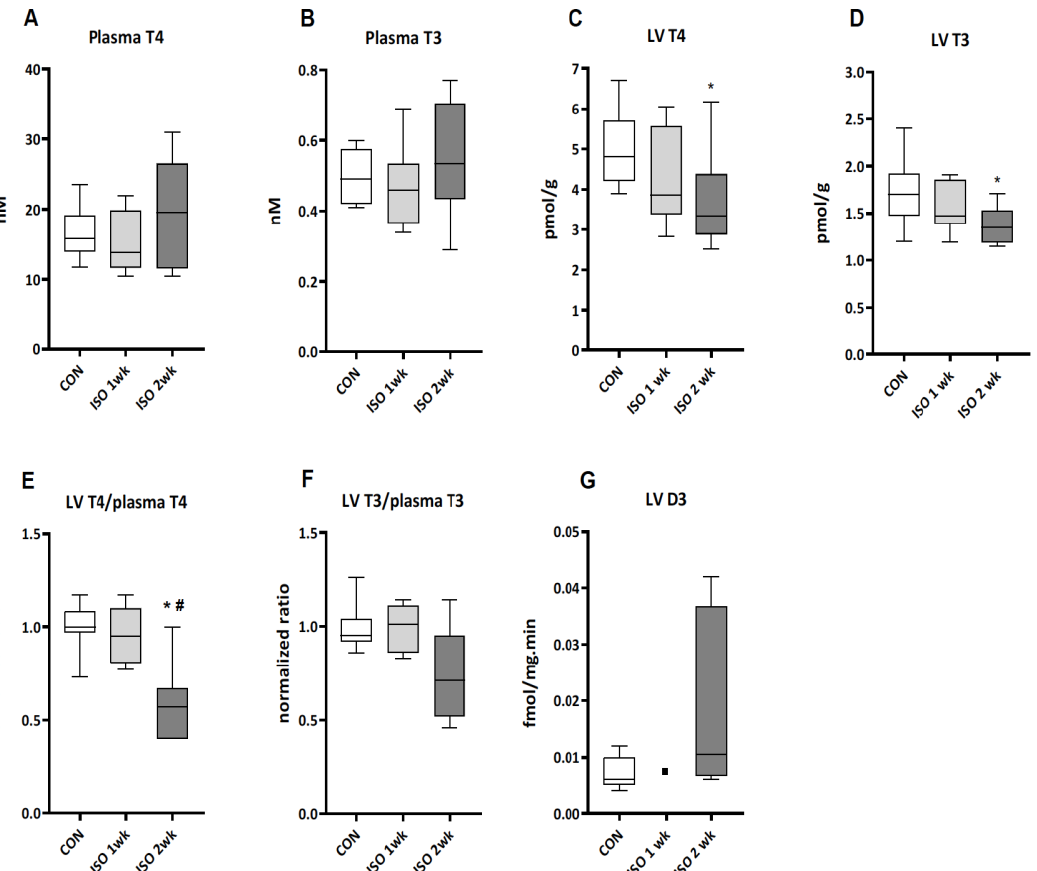
Figure 2. The effect of one and two weeks of ISO infusion on plasma and LV thyroid hormone levels and LV D3 activity. Plasma concentrations ( A , B ) and LV tissue content of T4 and T3 ( C , D ) were determined by tandem mass spectrometry. Tissue/plasma ratios ( E , F ) were normalized to the respective average control value. LV D3 activity ( G ) was determined in tissue homogenates by conversion of radiolabeled T4 followed by HPLC and quantification of metabolites. Data are presented as median and quartiles with whiskers indicating minimum and maximum values. ( A – F ): n = 8–10 for all groups; ( G ): CON: n = 5; ISO 1 wk: n = 1; ISO 2 wk: n = 6. Two-way ANOVA followed by unprotected Fisher’s LSD test was used to determine significance of differences. *: p < 0.05 vs. CON, #: p < 0.05 vs. 1 wk.